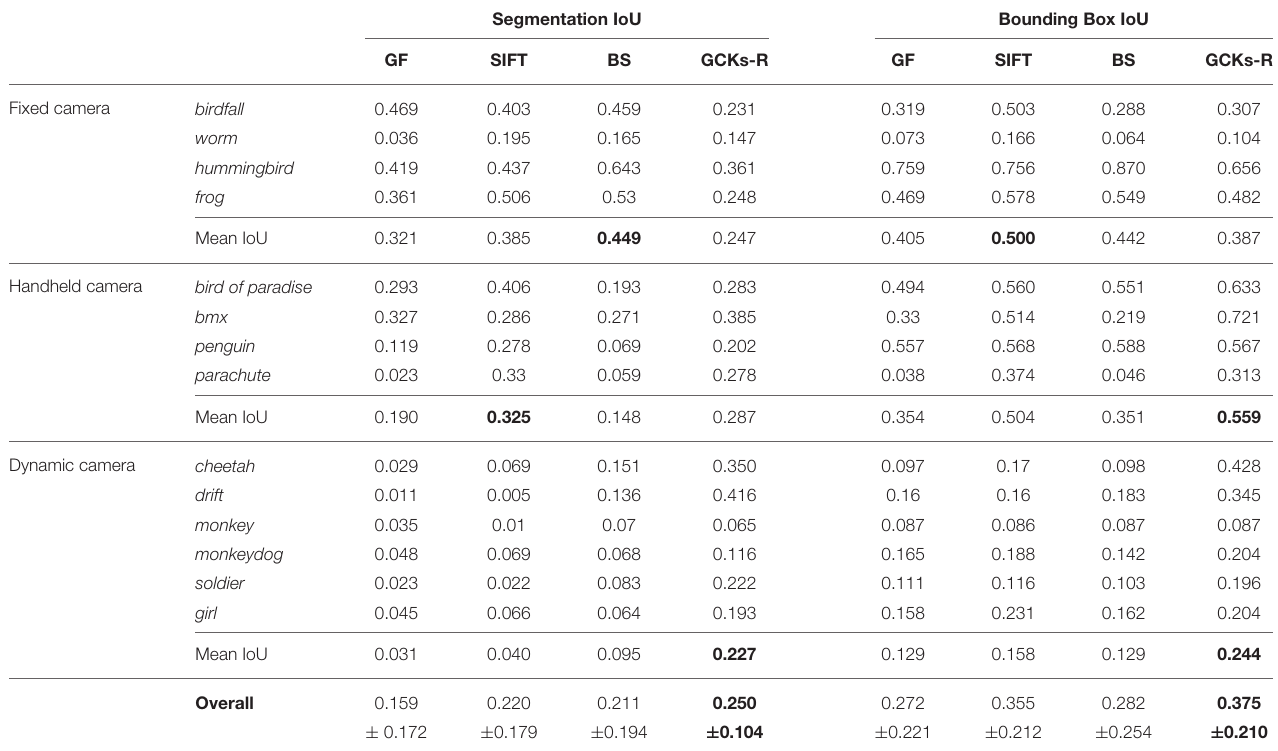
TABLE 1 | Evaluation of our motion-based pipeline on SegTrackv2 with respect to basic motion detection approaches, “GCKs-R” refers to the result of the complete pipeline described in Section